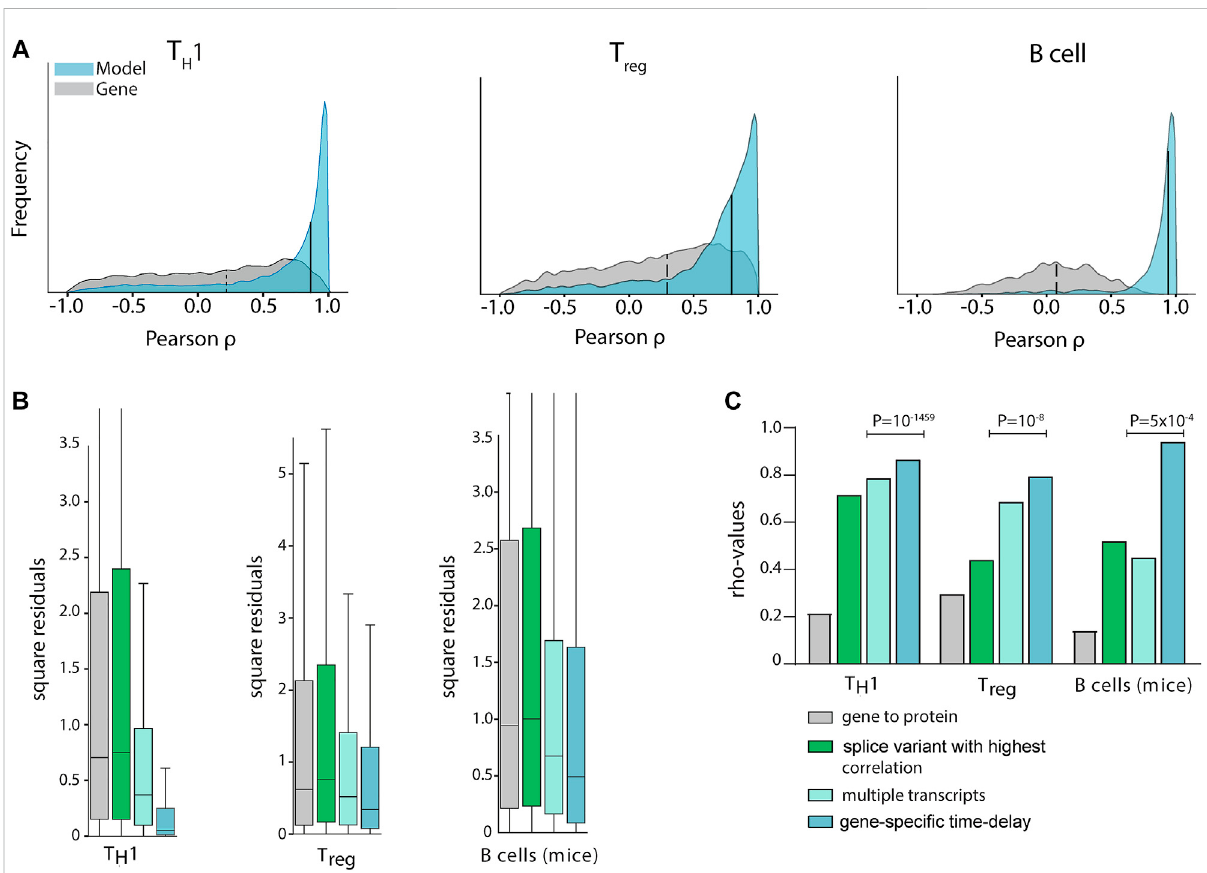
FIGURE 2 Multiple transcripts and time delays increased mRNA and protein correlations signi fi cantly in multiple cell types. (A) Gene/protein Pearson correlations in T H 1 (left), T reg (middle), and murine B-cell (right) differentiation. In the histogram, the grey curve shows the correlation distribution whenthesumofallsplicevariantexpressionsofatranscript(Fortelnyetal.,2017)isusedtoquantifymRNAabundance(median:dashedline),whilein the blue histogram our time delayed multiple splice variant based models are used (medians: solid lines at 0.86, 0.79, and 0.94 for T H 1, T reg and murine B-cells, respectively). Only cross-validated protein predictions are shown for the proteins for which the null-model could be rejected. (B) Out-of-sample cross validation prediction of the three models. Aiming to quantify the predictive power of each added input to the model, we observedthatalinearmodelwithgene-speci fi ctimedelayswasthemodelthatgeneratedpredictionswiththesmallestsumofsquaredresiduals. (C) Median correlation coef fi cients (rho) for different mathematical protein prediction models derived from mRNA with increasing protein abundance correlations. P-values were derived from predictions using leave-one-out